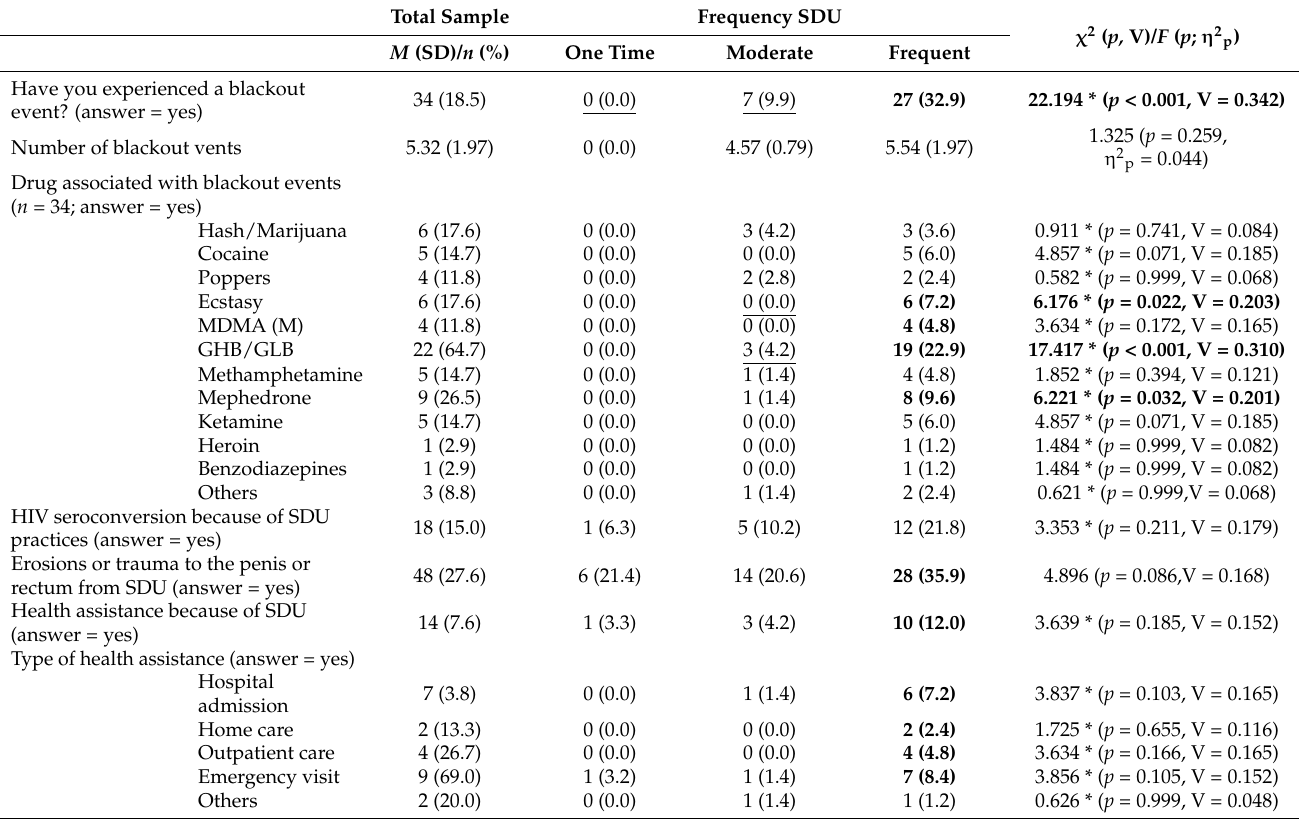
Table 3. Consequences of SDU Practices—Blackout Event, HIV, Erosions, and Health Assistance. Total